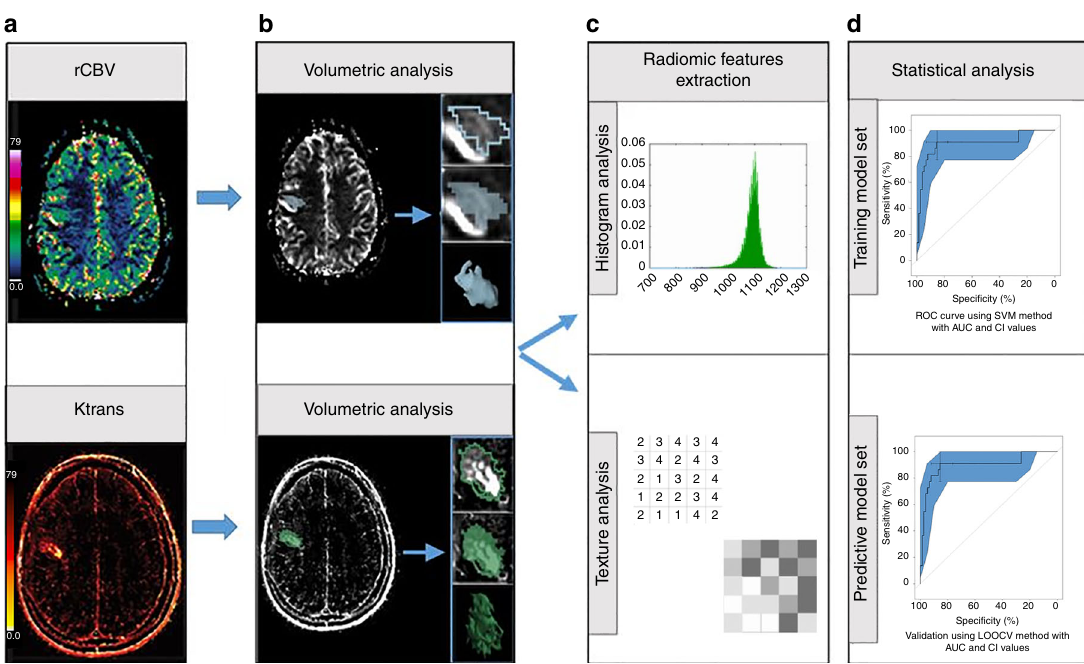
Fig. 1 Image post-processing radiomic work fl ow. a relative cerebral blood volume (rCBV) and K trans maps of perfusion MRI are acquired. b Segmentation of the region of interest using 3D slicer software. c Radiomic feature extraction from the whole tumor volume. d Statistical analysis: radiomic and clinical features are analyzed to determince their diagnostic and predictive